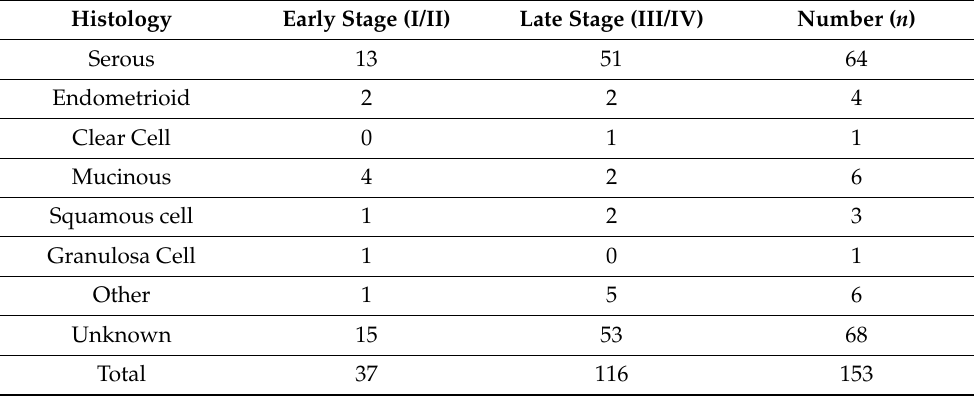
Table 8. Stage and histopathologic diagnosis of patient